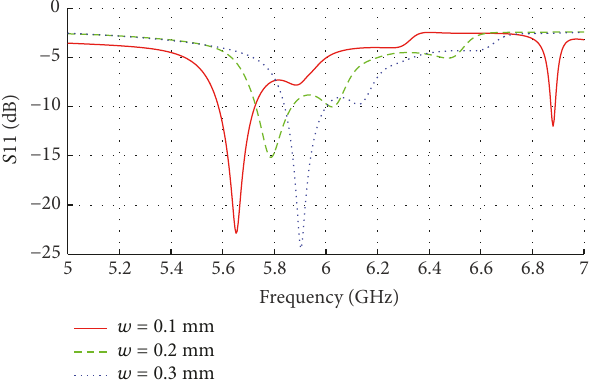
Figure 10: The optimization of width of the square ring.